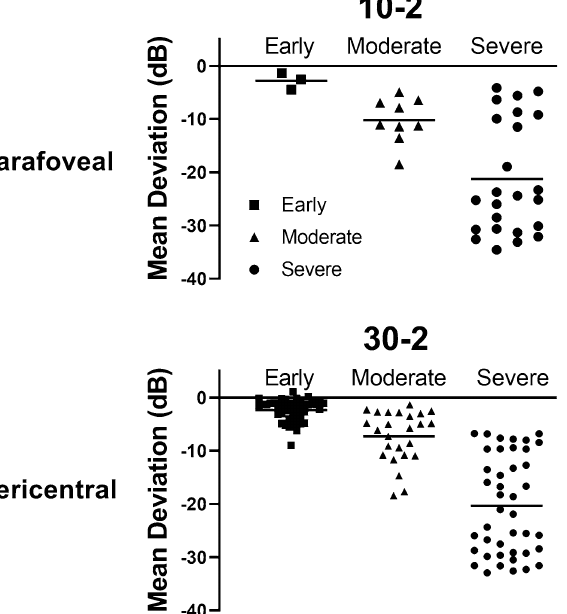
Figure 6. Mean deviation (MD) values on Humphrey 10–2 and 30–2 visual field tests in eyes with parafoveal and pericentral involvement, respectively, separated into severity groups according to the current